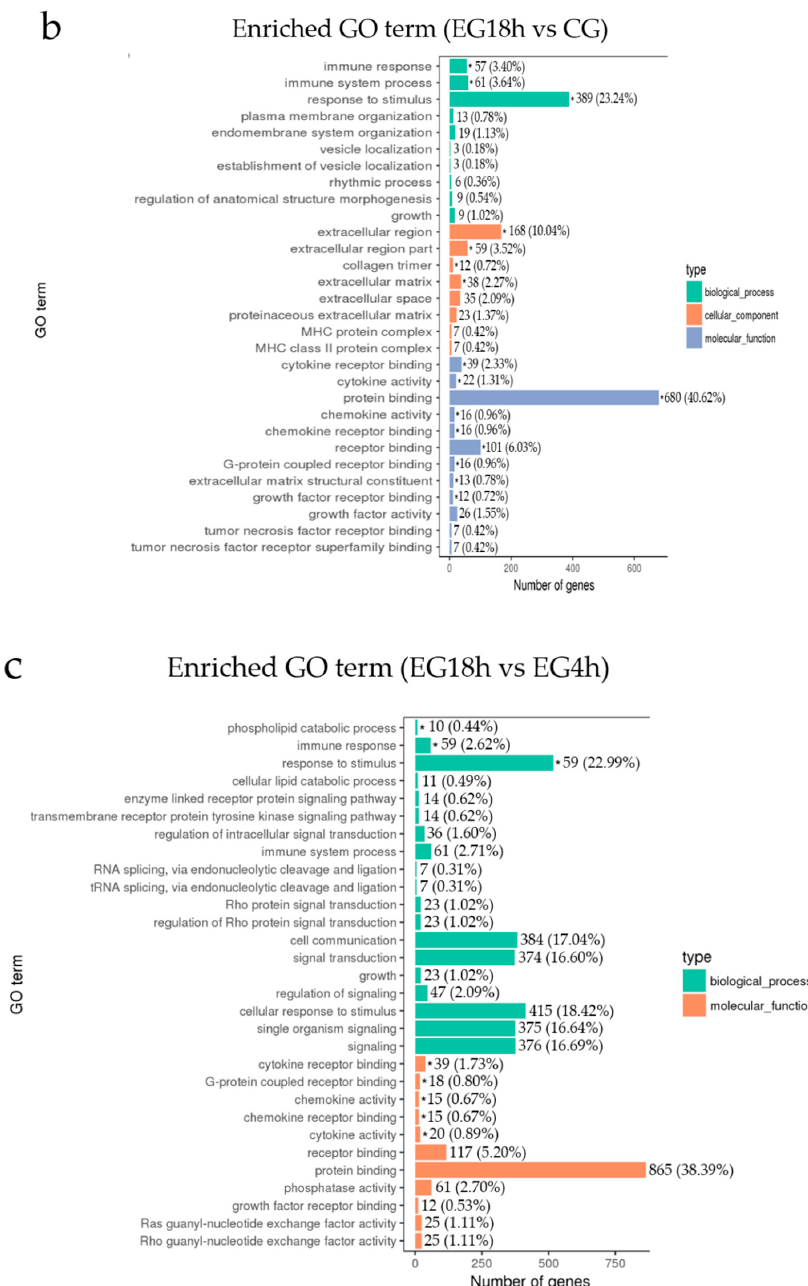
Figure 6. Gene ontology (GO) classification of the DEGs. Differentially expressed gene annotation hits were from the GO databases. We listed the most 30 enriched GO terms obtained between EG4h vs CG ( a ), EG18h vs CG ( b ), EG18h vs EG4h ( c ). The number of DEGs and their percentage in each GO terms were shown in the graph. * means significantly enriched ( p < 0.05).